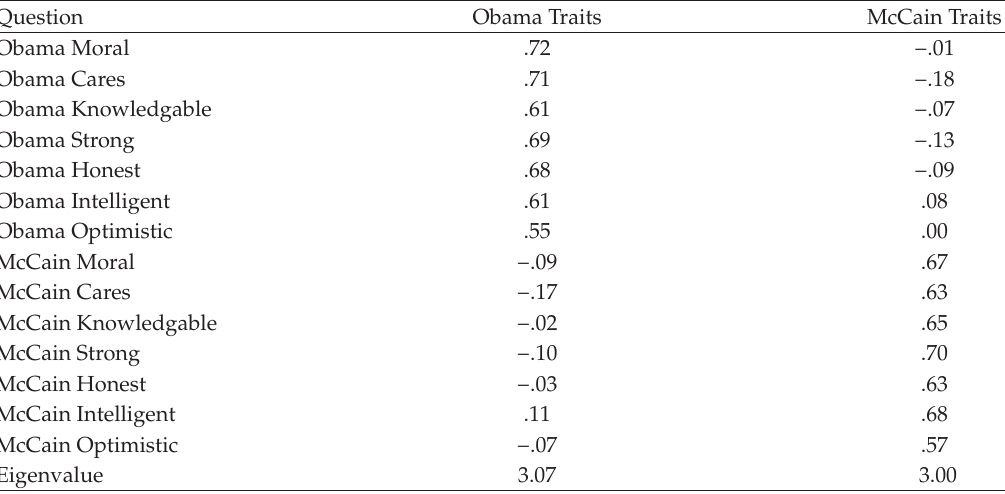
Table 5: Factor loadings for candidate traits scores